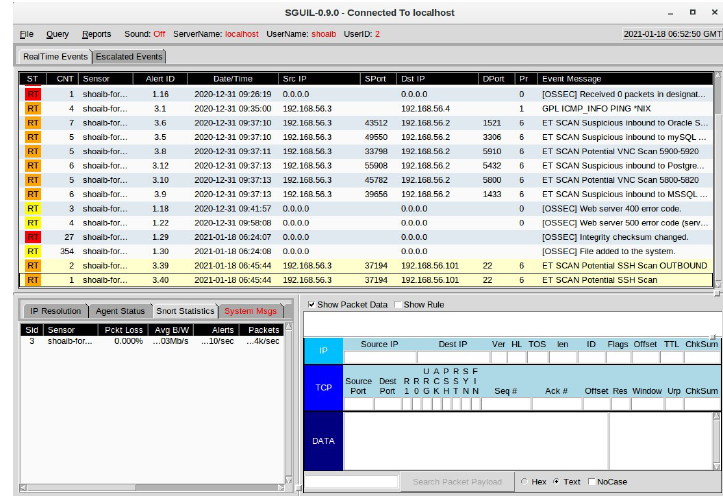
Figure 7. Sguil interface shows the alert for attacks.